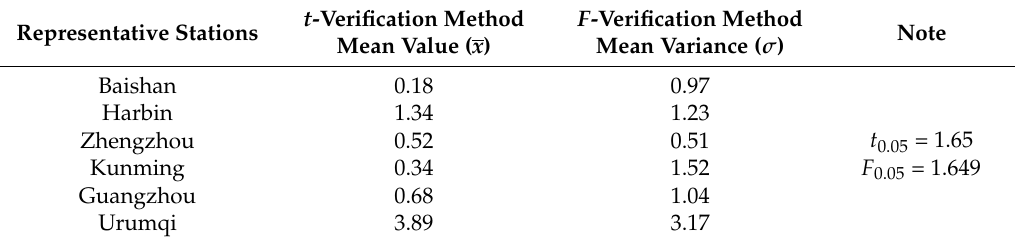
Figure 6. Variations in statistical parameters for annual precipitation at representative precipitation stations as sample size varies. Table 3. Statistical parameter hypothesis verification results for 30-year sample size of annual precipitation series from representative